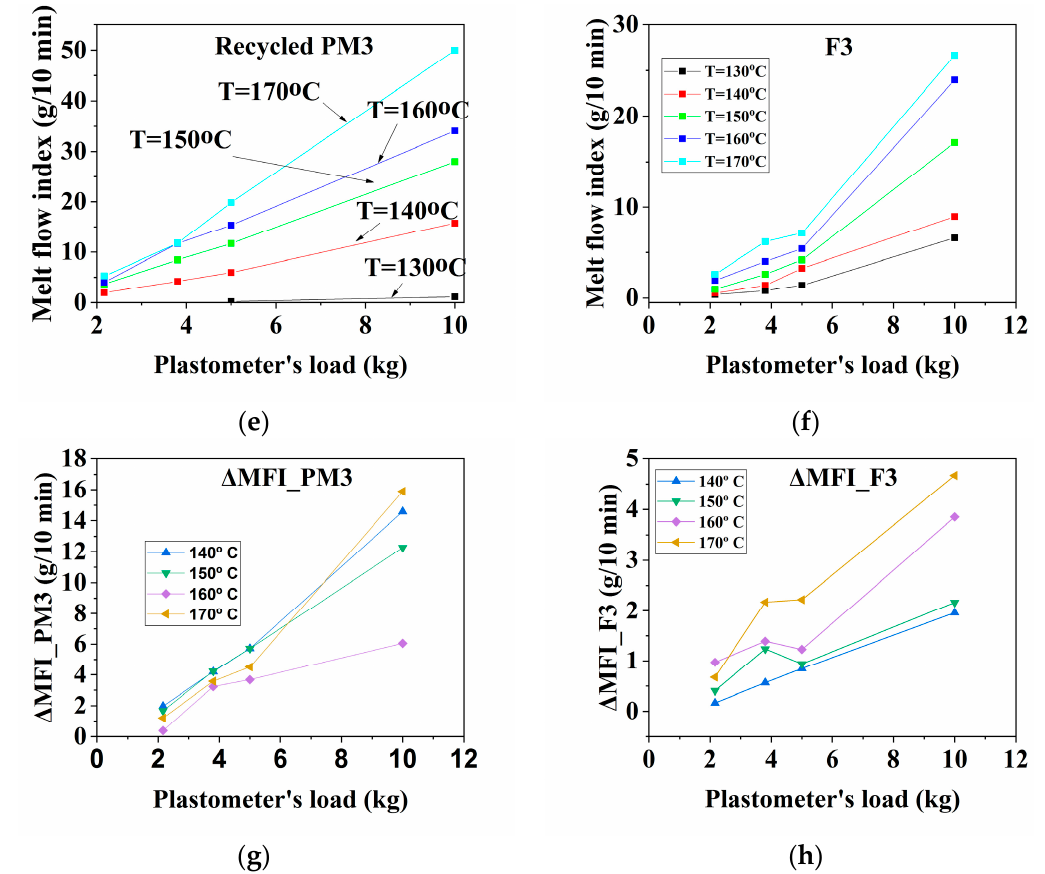
Figure 3. The melt rheological properties of the recycled PM3 compound ( a – d ) with those of the primary F3 ( e – h ) and their dependence on the flowing conditions (for PM3: ( a ) MFI = f(T); ( b ) Δ MFI = f(T); ( c ) MFI = f(G); ( d ) Δ MFI = f(G)); (For F3: ( e ) MFI = f(T); ( f ) Δ MFI = f(T); ( g ) MFI = f(G); ( h ) Δ MFI = f(G)).